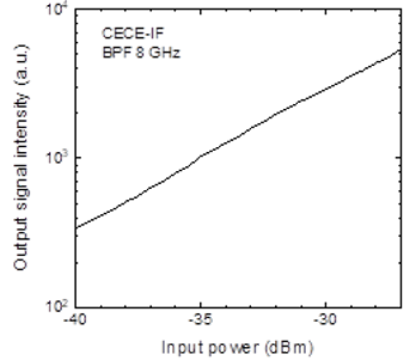
Fig. 6. Linearity of output voltage versus power applied to the 8 GHz IF line of the CECE-IF